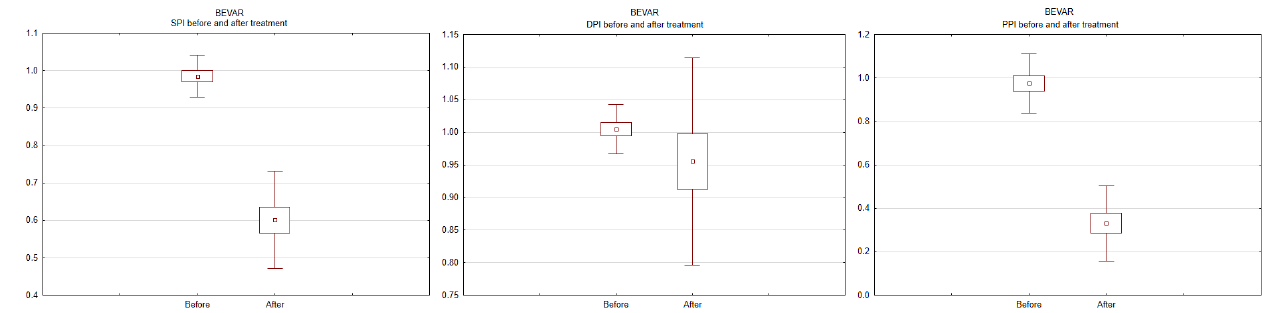
Figure 2. Systolic pressure index (SPI), diastolic pressure index (DPI), and pulse pressure index (PPI) at baseline and after branched endovascular aneurysm repair.